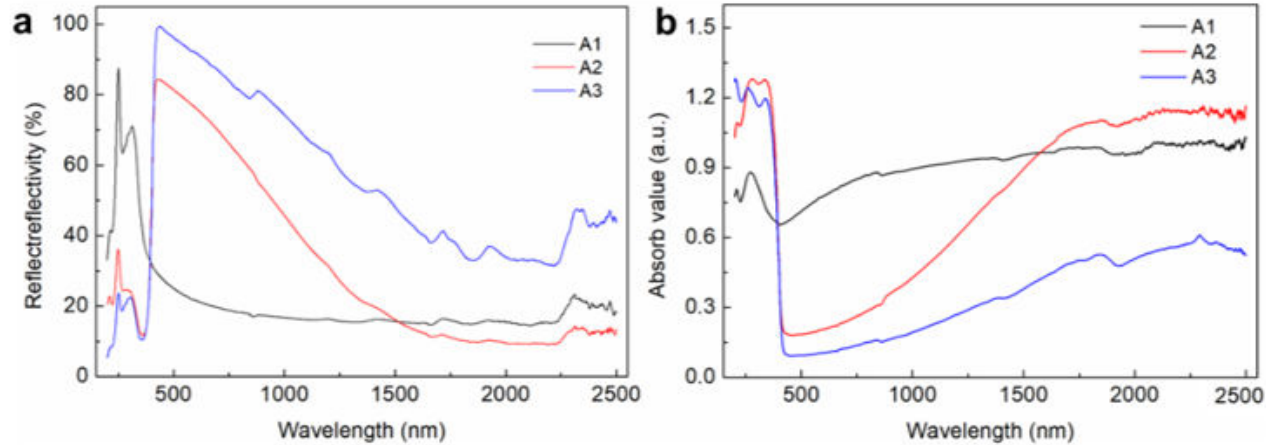
Figure 5. UV–Vis–NIR diffuse reflectance ( a ) and absorbance ( b ) spectra of the TiO 2 @ATO/AN